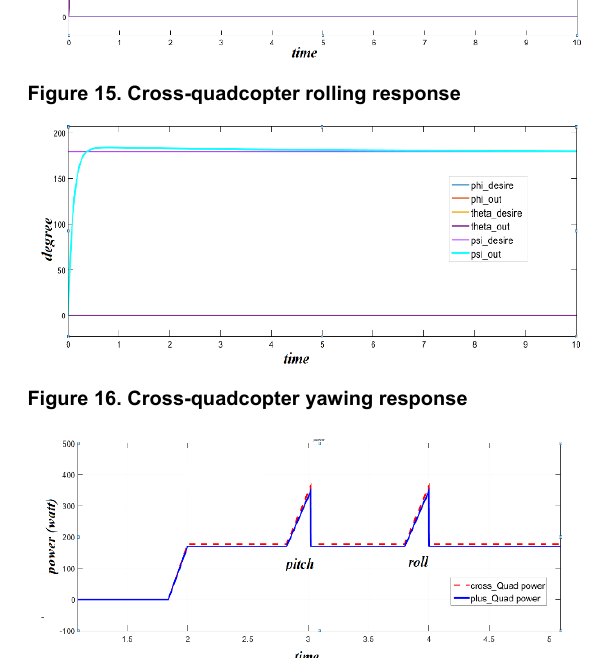
Figure 15. Cross-quadcopter rolling response